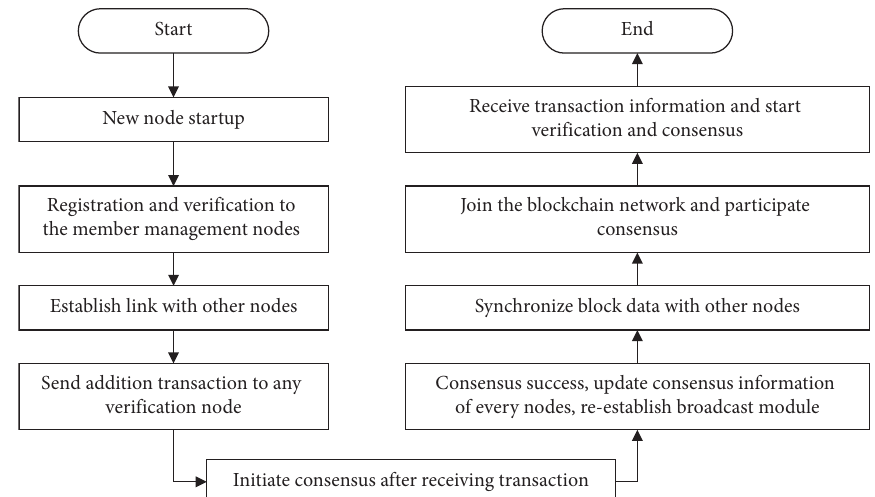
Figure 5: Process of dynamic addition of new verification